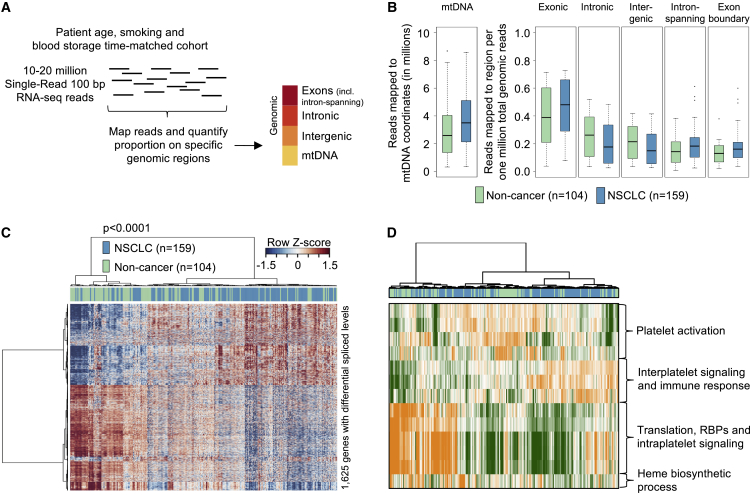
Analysis of the Spliced RNA Repertoire of TEPs from NSCLC Patients(A) Schematic figure represents the read distribution analyses procedure. A total of 100 bp reads were mapped to the human genome and reads mapping to four distinct regions were quantified. mtDNA, mitochondrial genome.(B) Boxplots indicate for non-cancer (green, n = 104) and NSCLC (blue, n = 159) the median and spread of reads mapping to mitochondrial (mtDNA), exonic, intronic, or intergenic regions, and the median and spread of intron-spanning and exon boundary reads (normalized to one million total genomic reads). The boxes of the boxplots indicate the IQR, the horizontal black line indicates the median values, and the whiskers range 1.5× the IQR.(C) Unsupervised hierarchical clustering of differentially spliced RNAs between non-cancer (n = 104) and NSCLC (n = 159) individuals, with FDR < 0.01. Columns indicate samples, rows indicate genes, and color intensity represents the Z score-transformed RNA expression values. Clustering of samples showed non-random partitioning (p < 0.0001, n = 263, Fisher's exact test).(D) PAGODA GO analysis. Most significant results by adjusted Z score, indicating high statistical significance, were clustered and visualized. Color code indicates a green-to-orange (low-to-high) score per sample per gene cluster.See also Table S2.